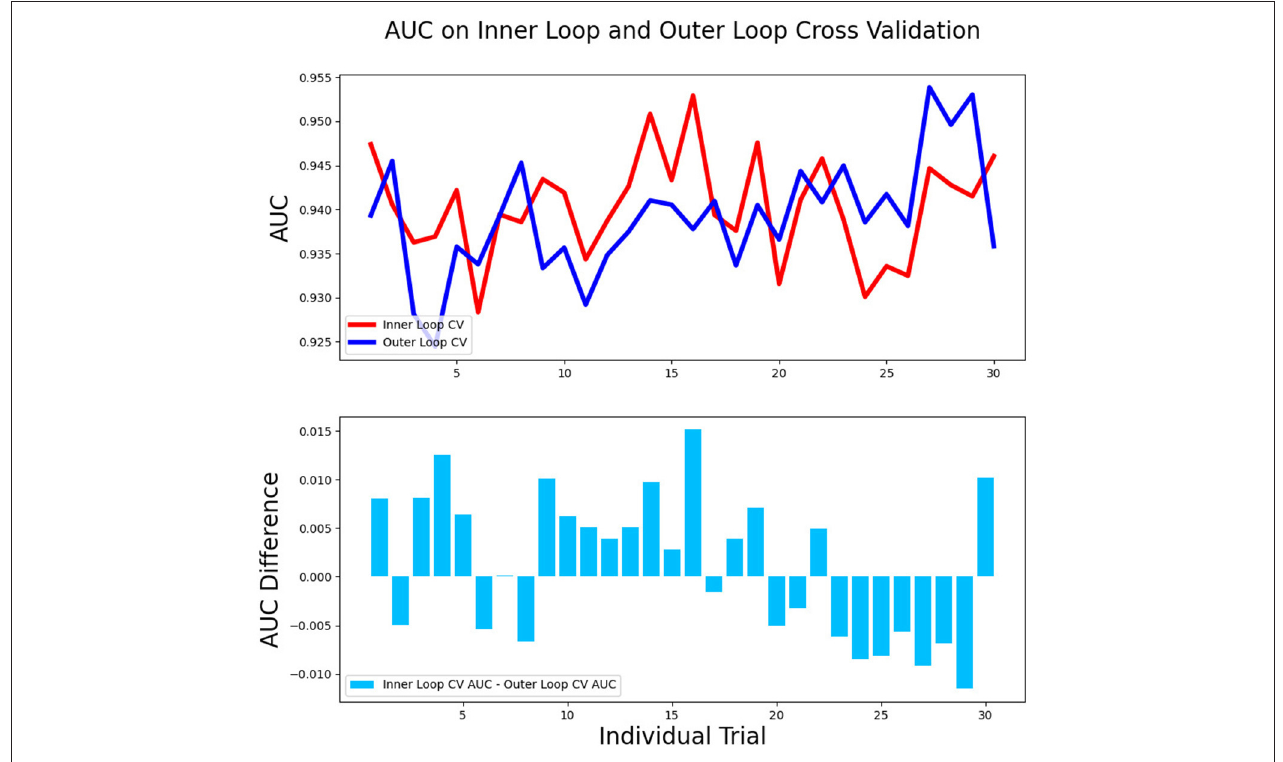
FIGURE 6 | The AUC between the validation dataset in the inner loop and testing dataset in the outer loop for 30-round